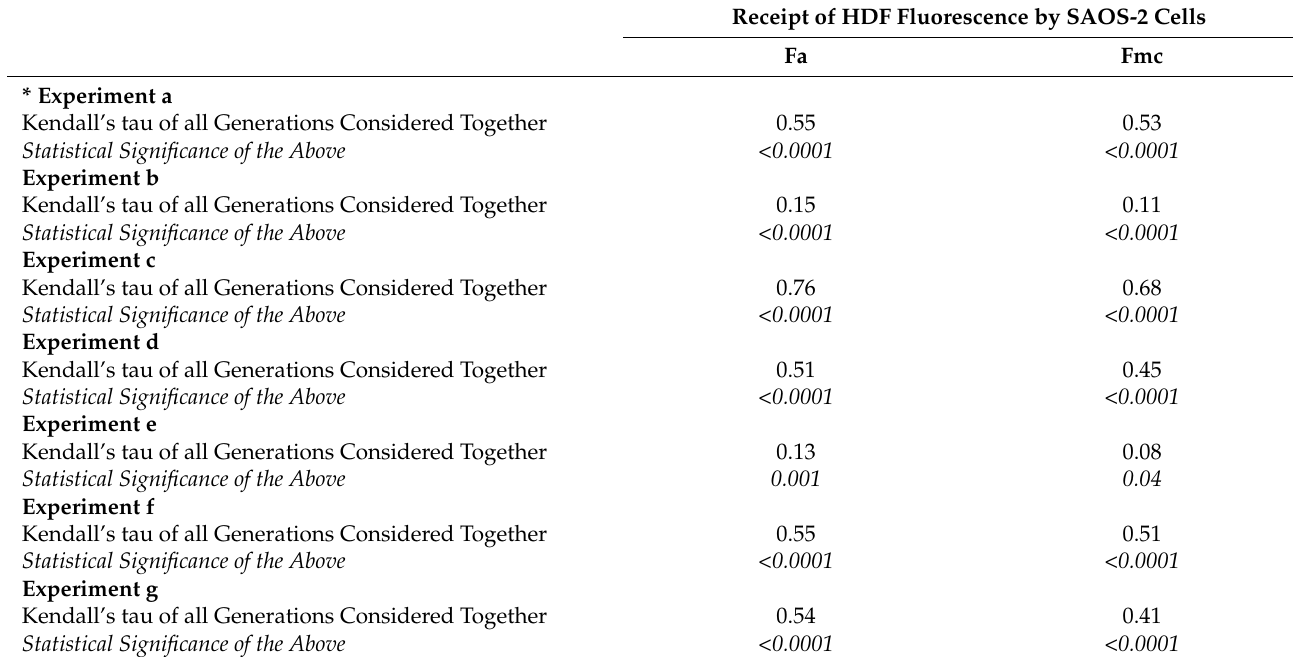
Table 1. Kendall’s tau of correlation between cell-profile area of tracked SAOS-2 cells and absolute fluorescence acquired from co-cultured HDFs (Fa), as well as compensation for halving of fluorescence from mother cells by cell division (Fmc). Results for all experiments are shown, considering all generations of cells counted together. Results for other groupings of successive generations of cells are in Supplementary Materials, Table S4.